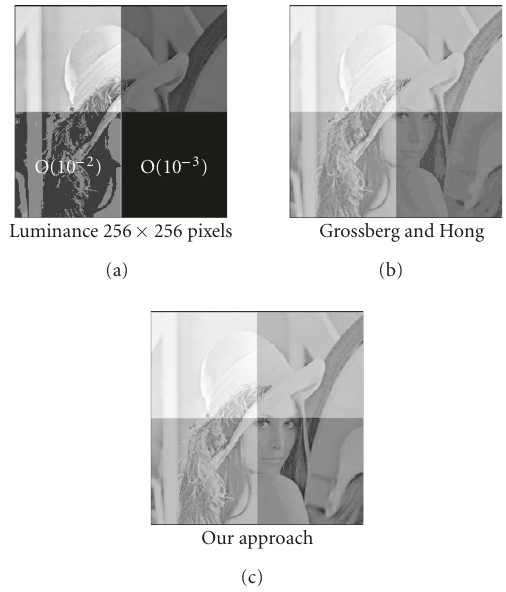
Figure 7: Tiled Lena image : the original Lena image (with lumi- nance values between 0 and 1, see Figure 11) was subdivided into four tiles, and tiles were multiplied with 10 0 , 10 − 1 , 10 − 2 , and 10 − 3 , respectively. In the input (a), both of the lower tiles are displayed in black. The order of magnitude of the corresponding luminance range is indicated with the black tiles.